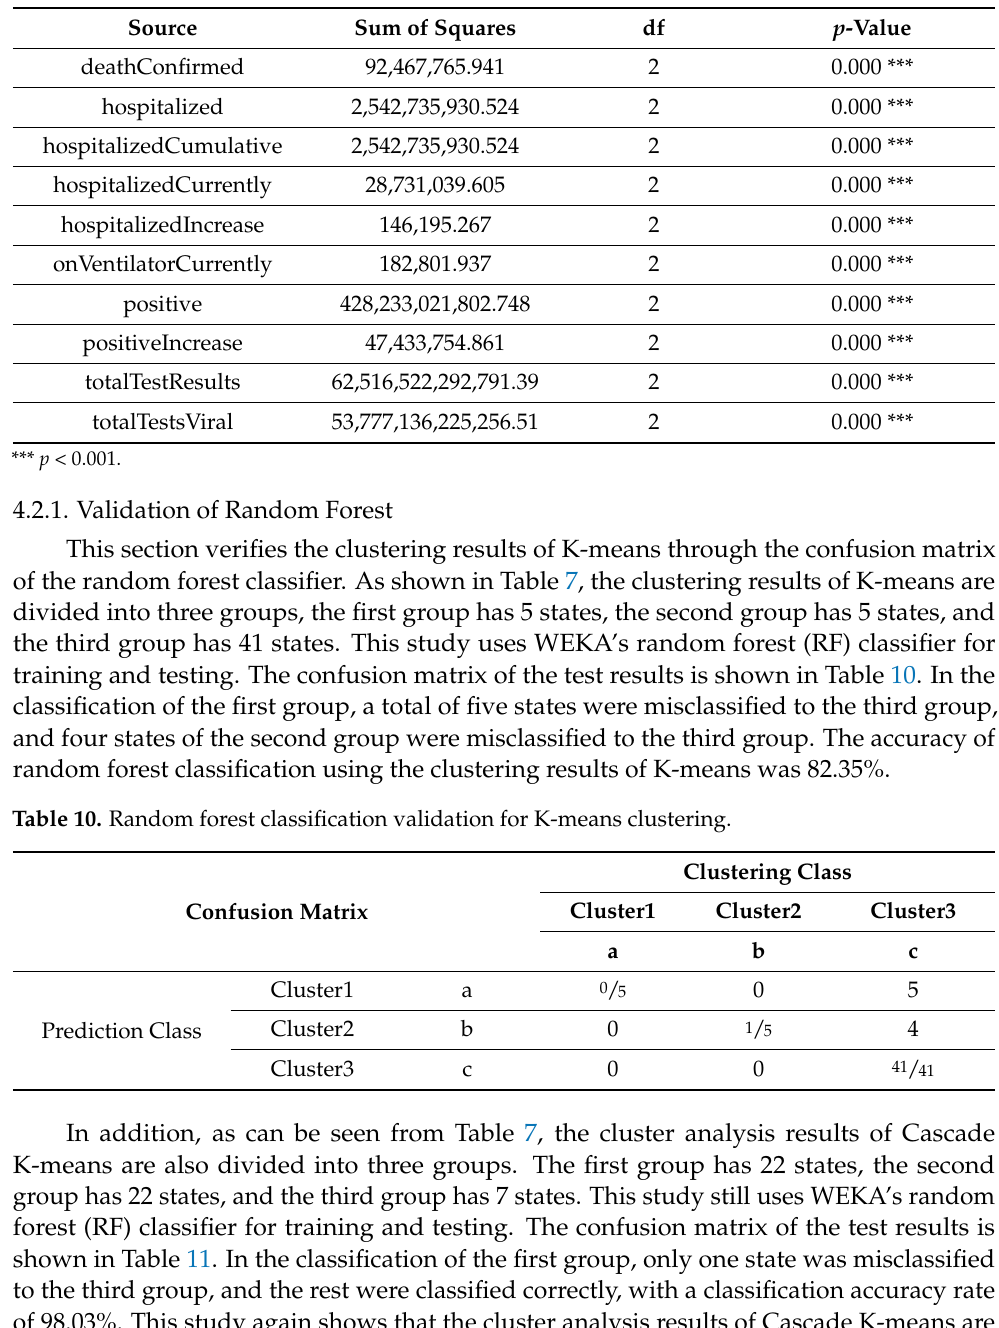
Table 9. ANOVA analysis results with Cascade K-means clustering.